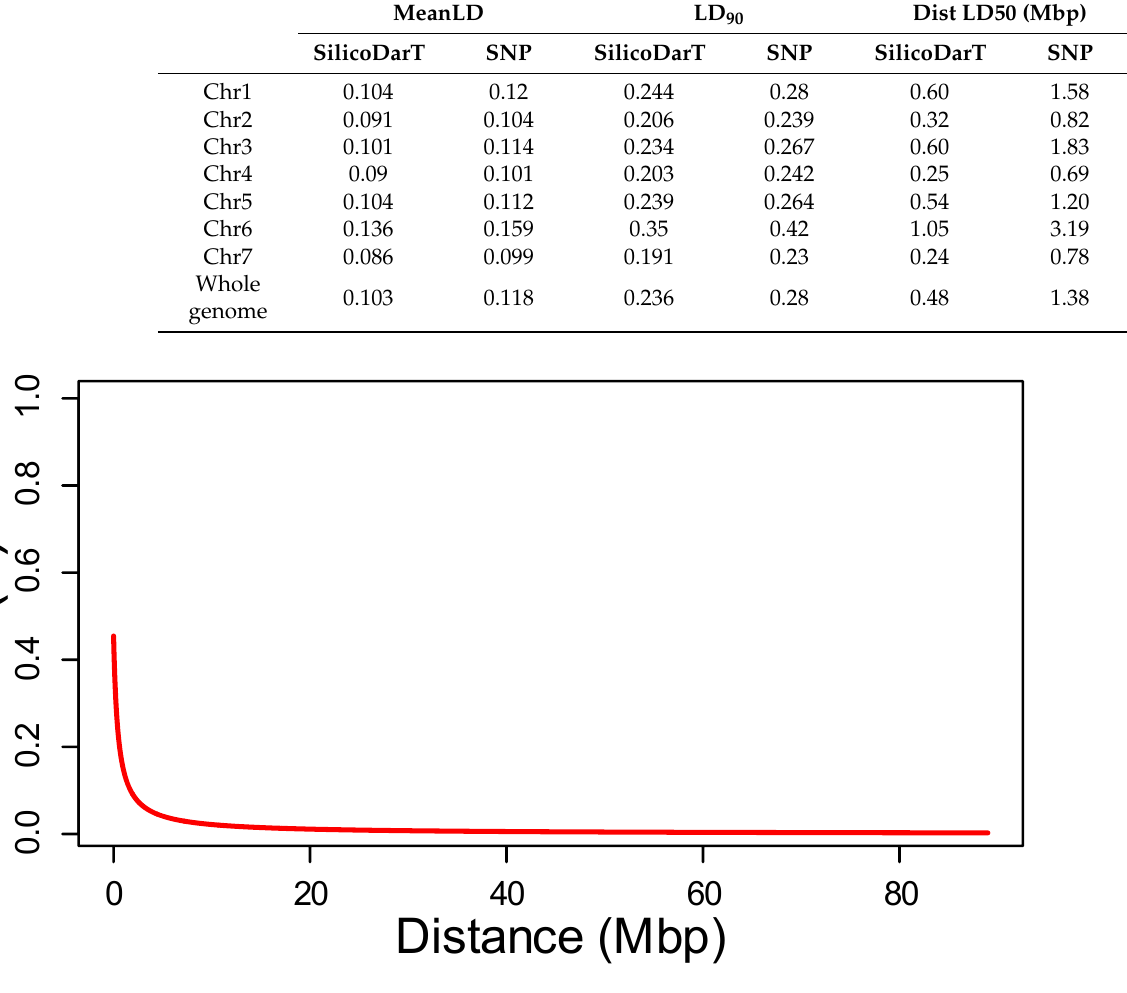
Table 4. Critical values of LD and LD-decay distance estimated for the DArTSeq markers. MeanLD